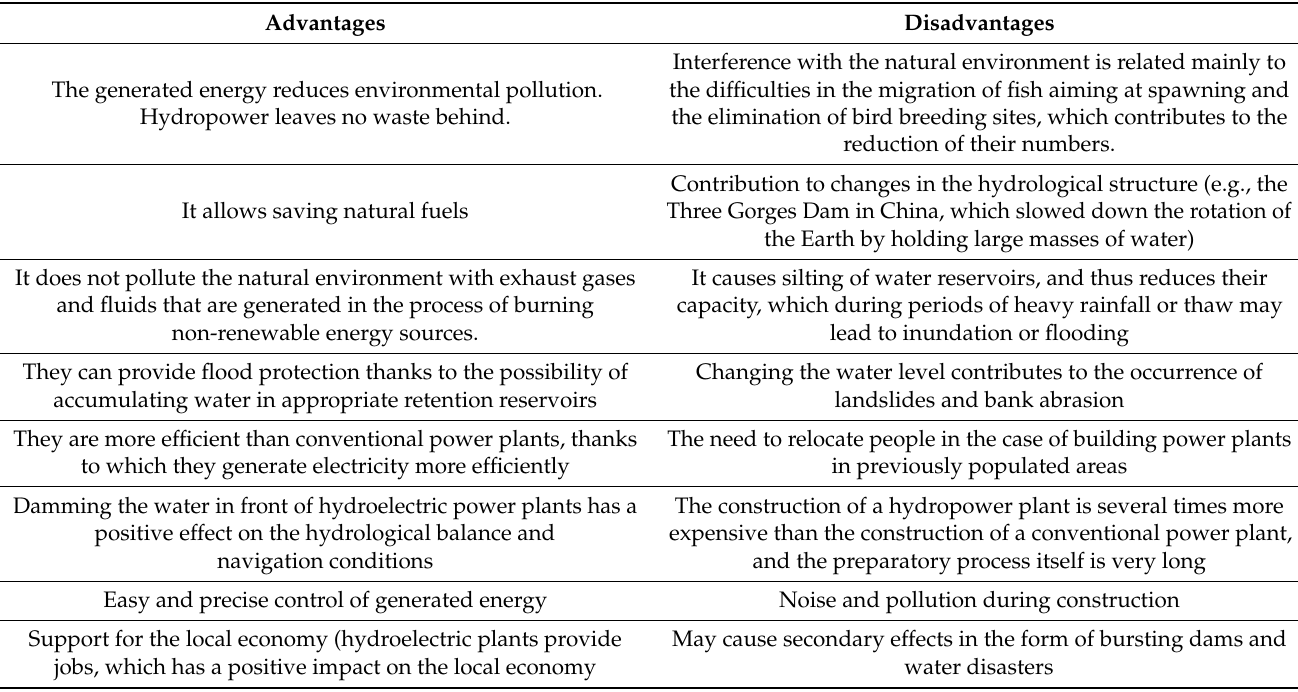
Table 9. Advantages and disadvantages of